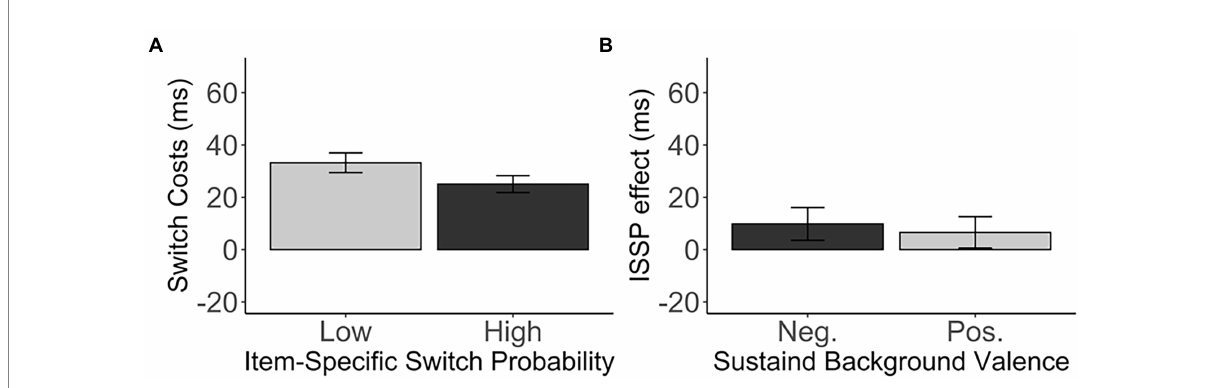
FIGURE 3 (A) The switch costs (in ms) of the low and high switch probability items in the medium, unbiased list-wide switch probability list. (B) The ISSP effect (in ms) as a function of the sustained background valence. Error bars indicate the standard error of the mean. Neg., Negative valence; Pos., Positive